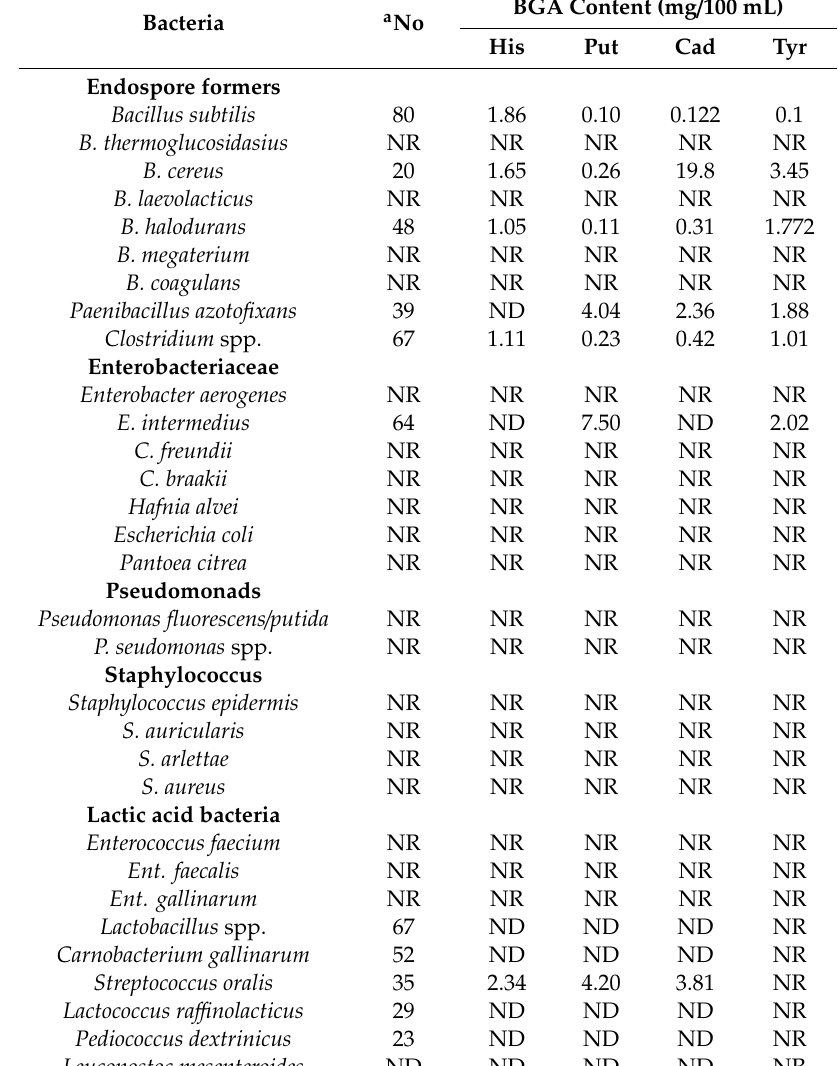
Table 5. Bacterial isolates from sorghum beer ( umqombothi ) and the amounts of biogenic amines each produced in decarboxylase